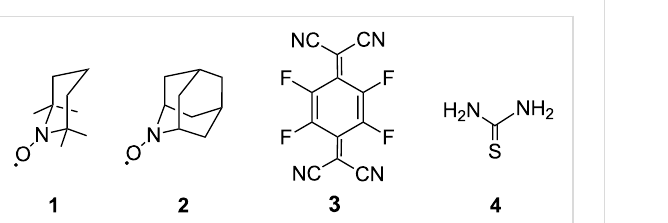
Figure 1: Structural formula of TEMPO ( 1 ), AZADO ( 2 ), TCNQF 4 ( 3 ) and thiourea ( 4 ).